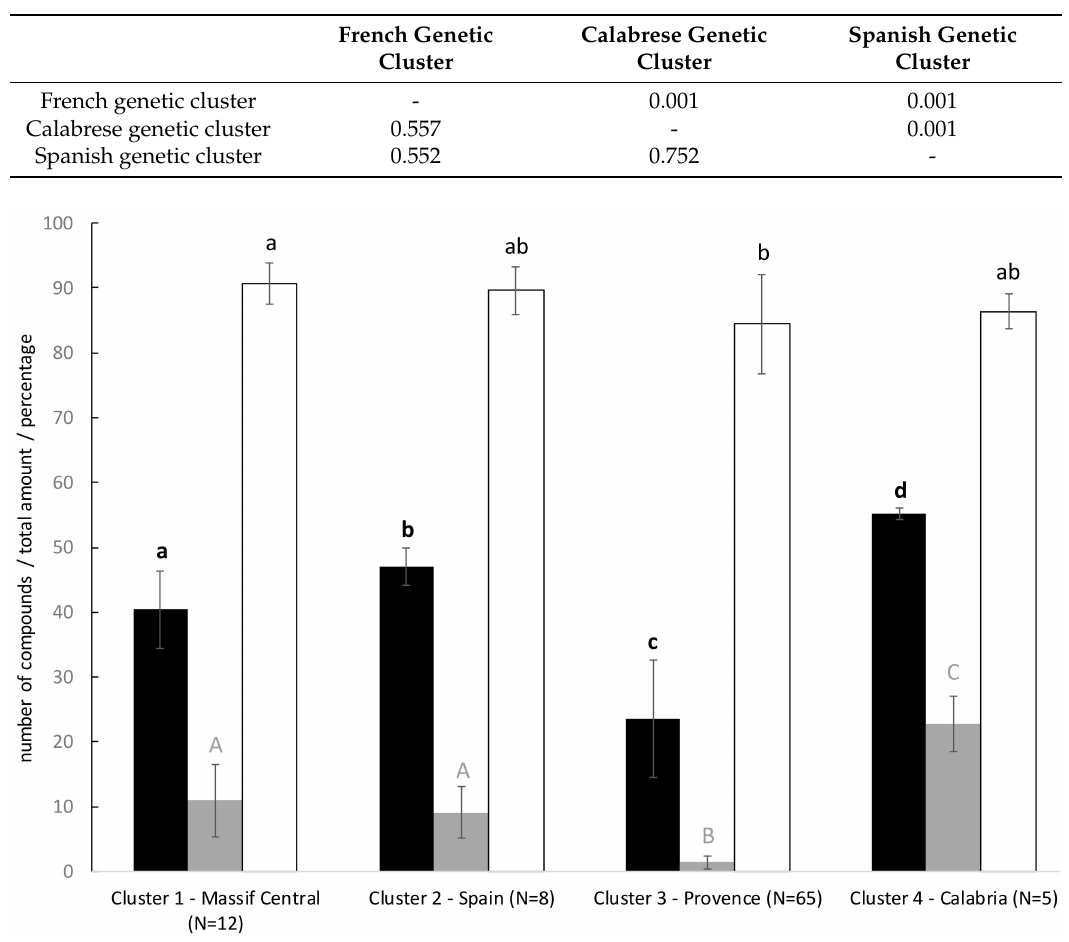
Table 4. Pairwise PHI PT values between genetic clusters (below diagonal) and probability associated with the permutation test for pairwise di ff erentiation (above diagonal; 999 permutations). The significance level was set to p = 0.05.